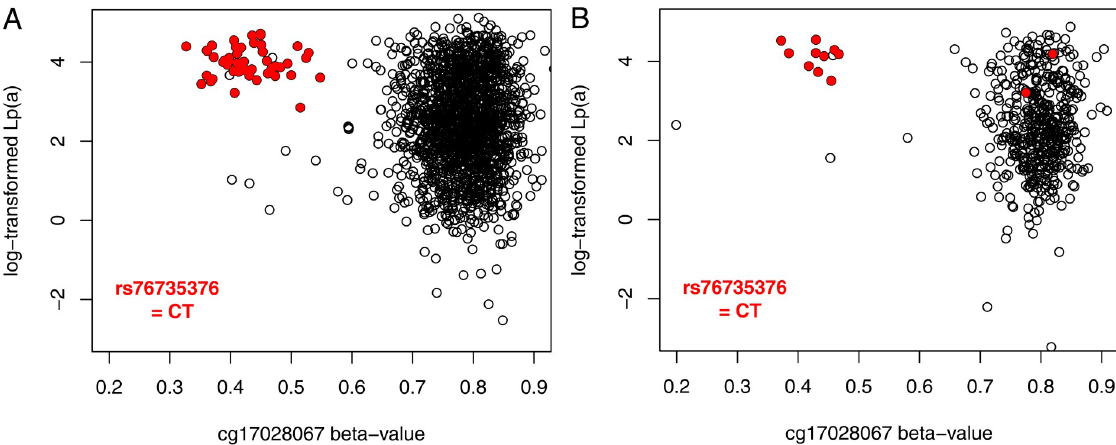
Fig 1. Association of methylation levels with Lp(a) values. Relationship of methylation level at cg17028067 (x axis), Lp(a) values (log- transformed (y axis) and rs76735376 genotype in the KORA F4 (panel A, n = 1724) and KORA F3 study (panel B, n = 484). Heterozygous carriers of rs76735376 (n = 49 in KORA F4, n = 12 in KORA F3) show roughly halved methylation levels and higher Lp(a) levels with less